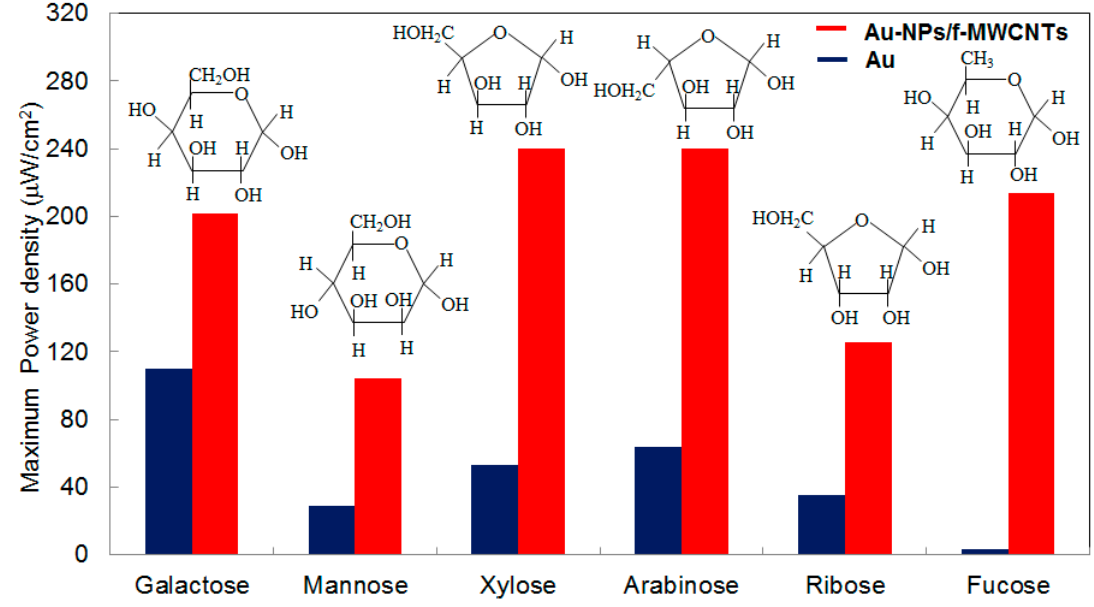
Figure 5. Power density of monosaccharide-based fuel cells using AuNPs/fMWCNTs as anodic catalyst in comparison with bare Au electrode. Reprinted with permission from ref. [66]. Copyright 2011, Elservier.